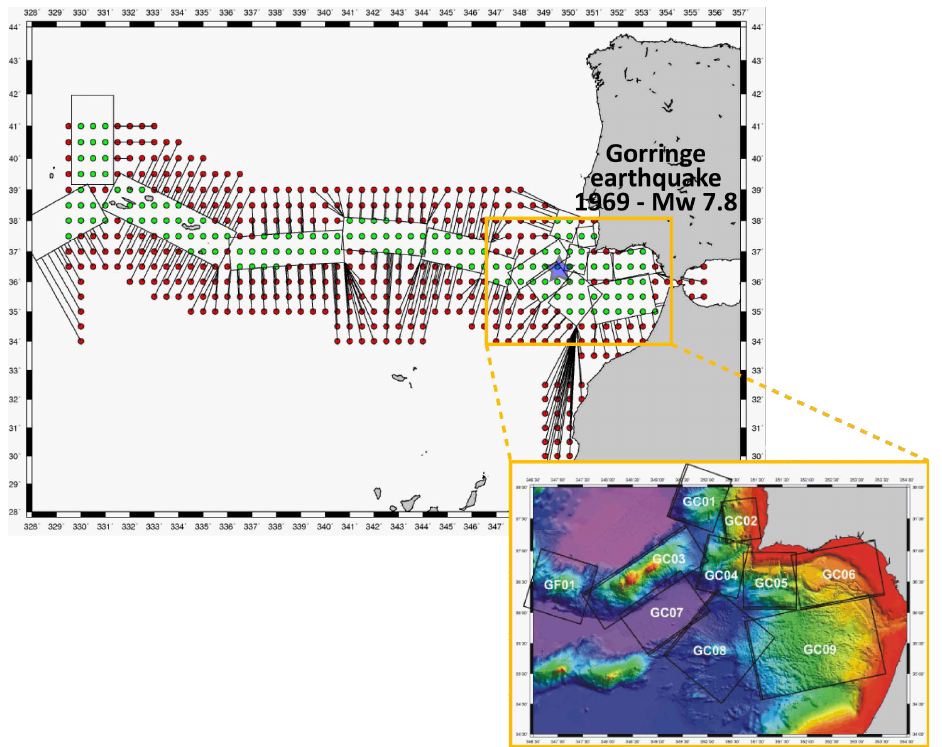
Fig. 14. Location of the 1969 Gorringe earthquake (blue star) superimposed on the simplified source location for the precomputed tsunami scenarios along the Azores-Gibraltar transform zone, taken from the TAT/JRC source definition in this area (L. Matias, personal communi- cation,